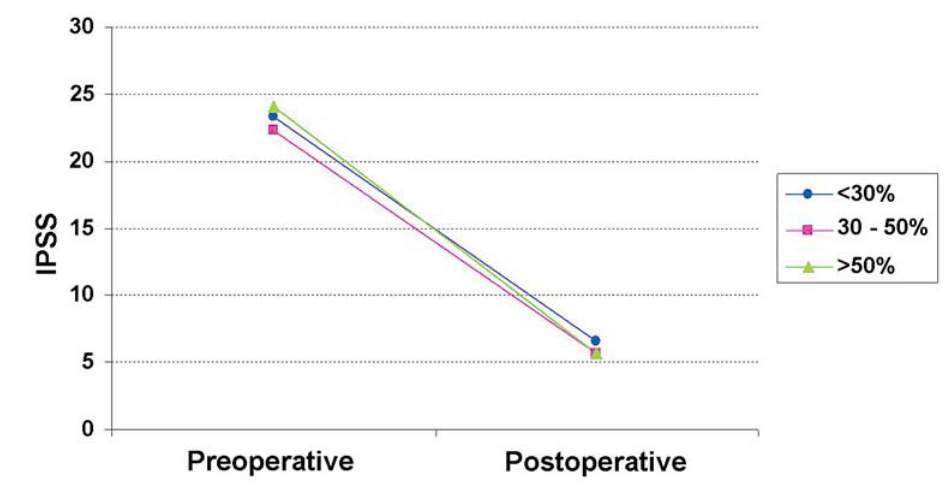
Figure 2 – Variation of International Prostate Symptom Score (IPSS) according to percentage of resected